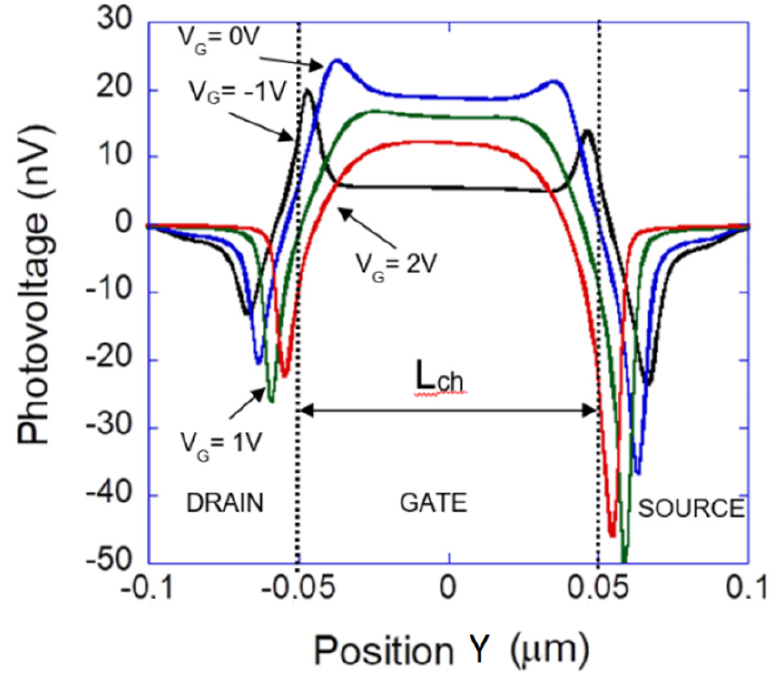
Figure 4. Variation in DC of photovoltage along X cut, at x = 0 beside the silicon–oxide interface. Dotted lines represent the limits of the channel.